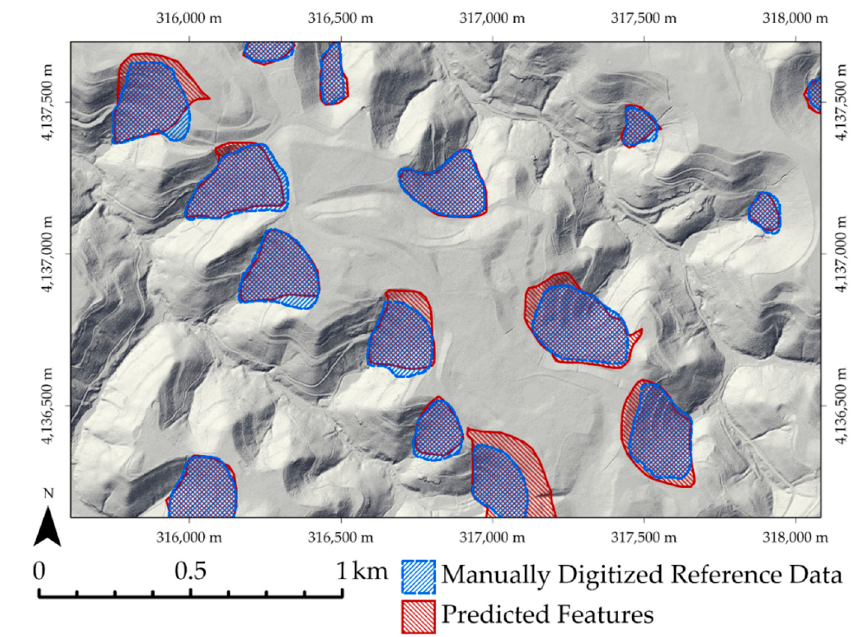
Figure 10. Example of predicted and manually digitized valley fill faces. The hillshade was derived from LiDAR data provided by the USGS 3DEP program. The coordinate grid represents easting and northing relative to the NAD83 UTM Zone 17 North projection.